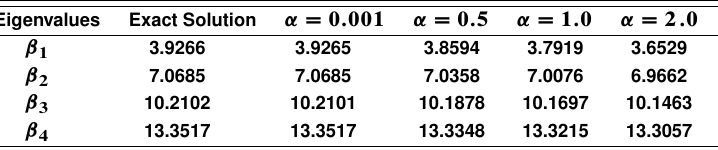
Table 1. The first four natural frequencies for different values of nonhomogeneity